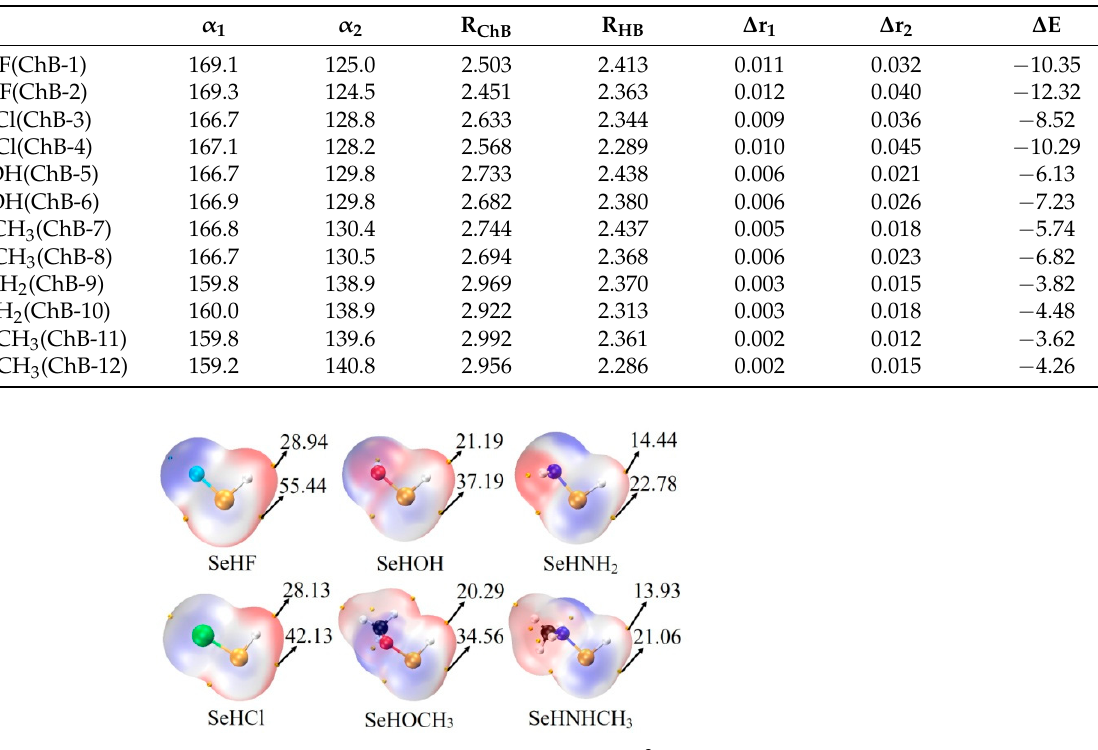
Figure 2. MEP maps on the 0.001 electrons Bohr − 3 isodensity surface of monomers. Red and blue regions represent positive and negative MEPs, respectively. All are in kcal/mol.